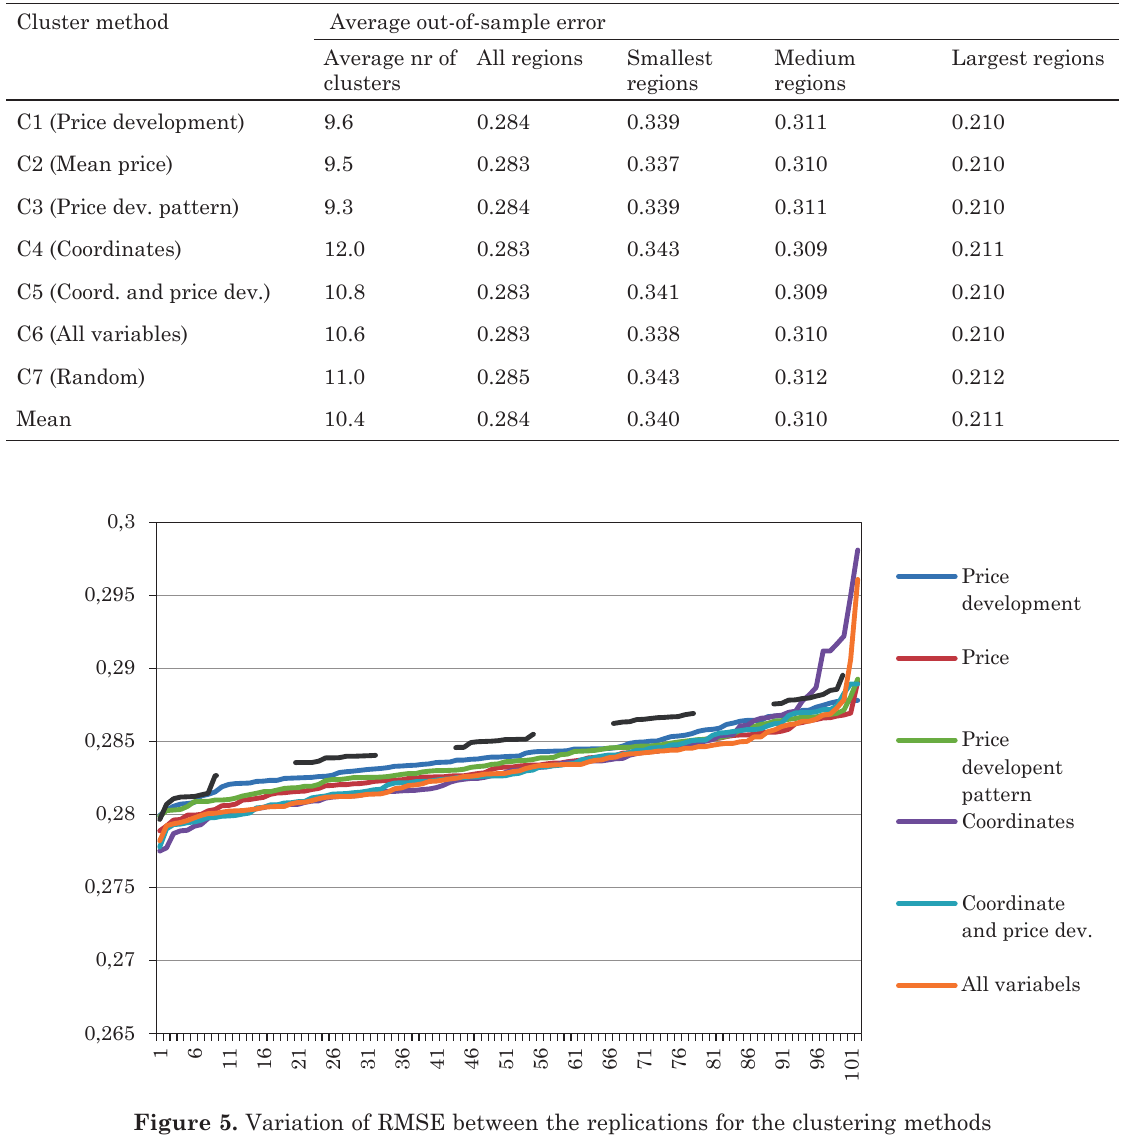
Table 6. Comparison of different clustering methods